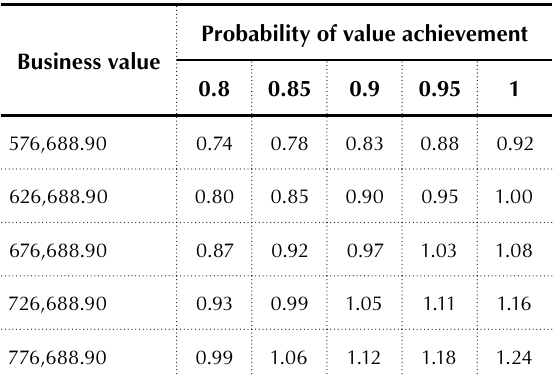
Table 2. Calculation of the index of strategic = $324,753.66 and adaptability for PV 0 I = $300,000.